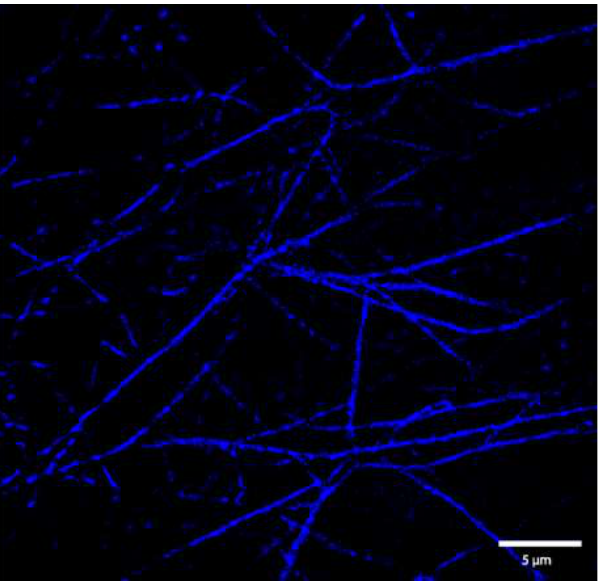
Figure 7. Stochastic optical reconstruction microscopy (STORM) image of a clot formed from 0.5 mg/mL fibrinogen and 0.1 NIH-U/mL thrombin (in HBS buffer + 5 mM calcium chloride), with AlexaFluor-647 labeled fibrinogen added at a concentration of 1/65 that of the wild-type fib- rinogen to allow for fluorescence imaging, obtained on a Nikon Ti2-E inverted microscope using a 100 × oil